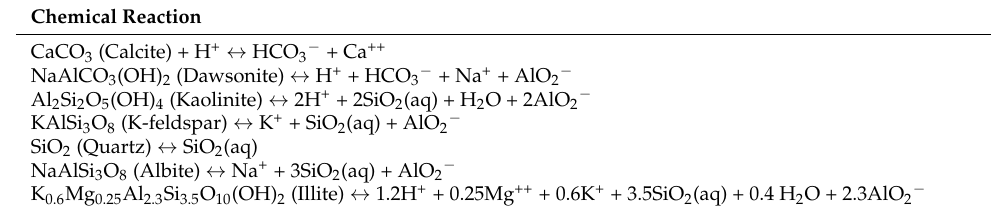
Table 6. List of main geochemical reactions considered in the model. Chemical